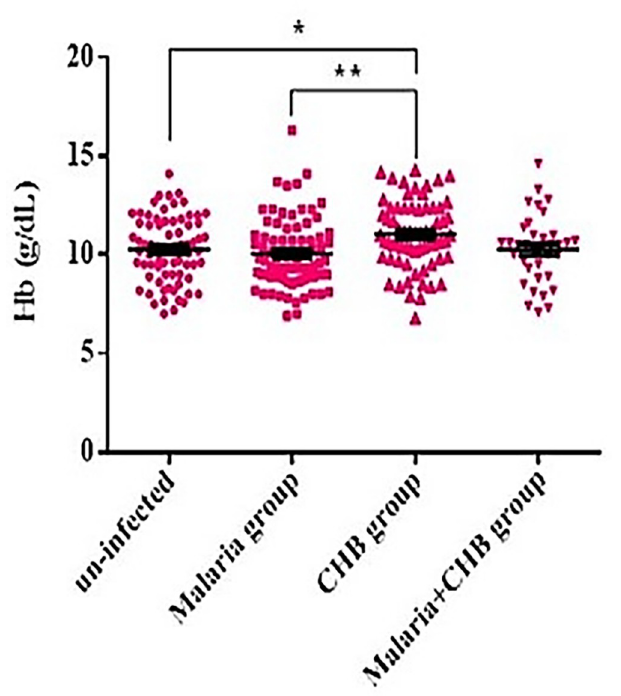
Fig 1. Comparison of levels of hemoglobin (Hb) amongst the groups of pregnant women. Pair-wise differences between the groups was tested by the Tukey’s multiple comparisons test with Tukey’s correction, � P = 0.043, �� P = 0.004. Horizontal bar with error bars represents the mean and standard error of mean respectively.